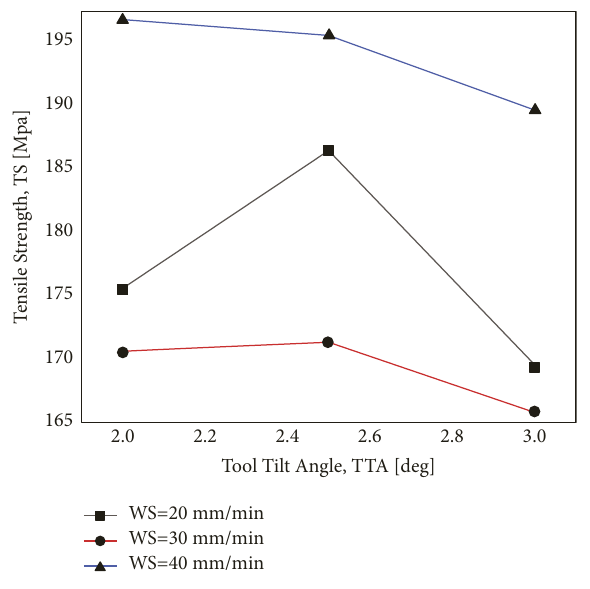
Figure 7: Influence of TRS -1100rpm on TS.